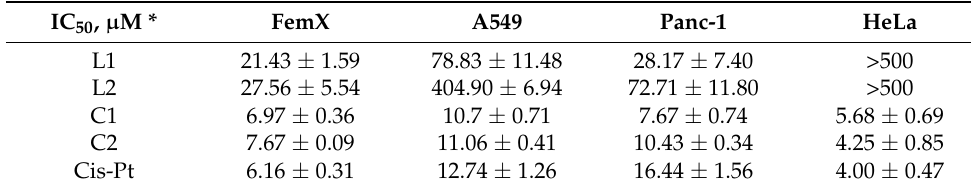
Table 1. IC 50 values of the tested compounds and